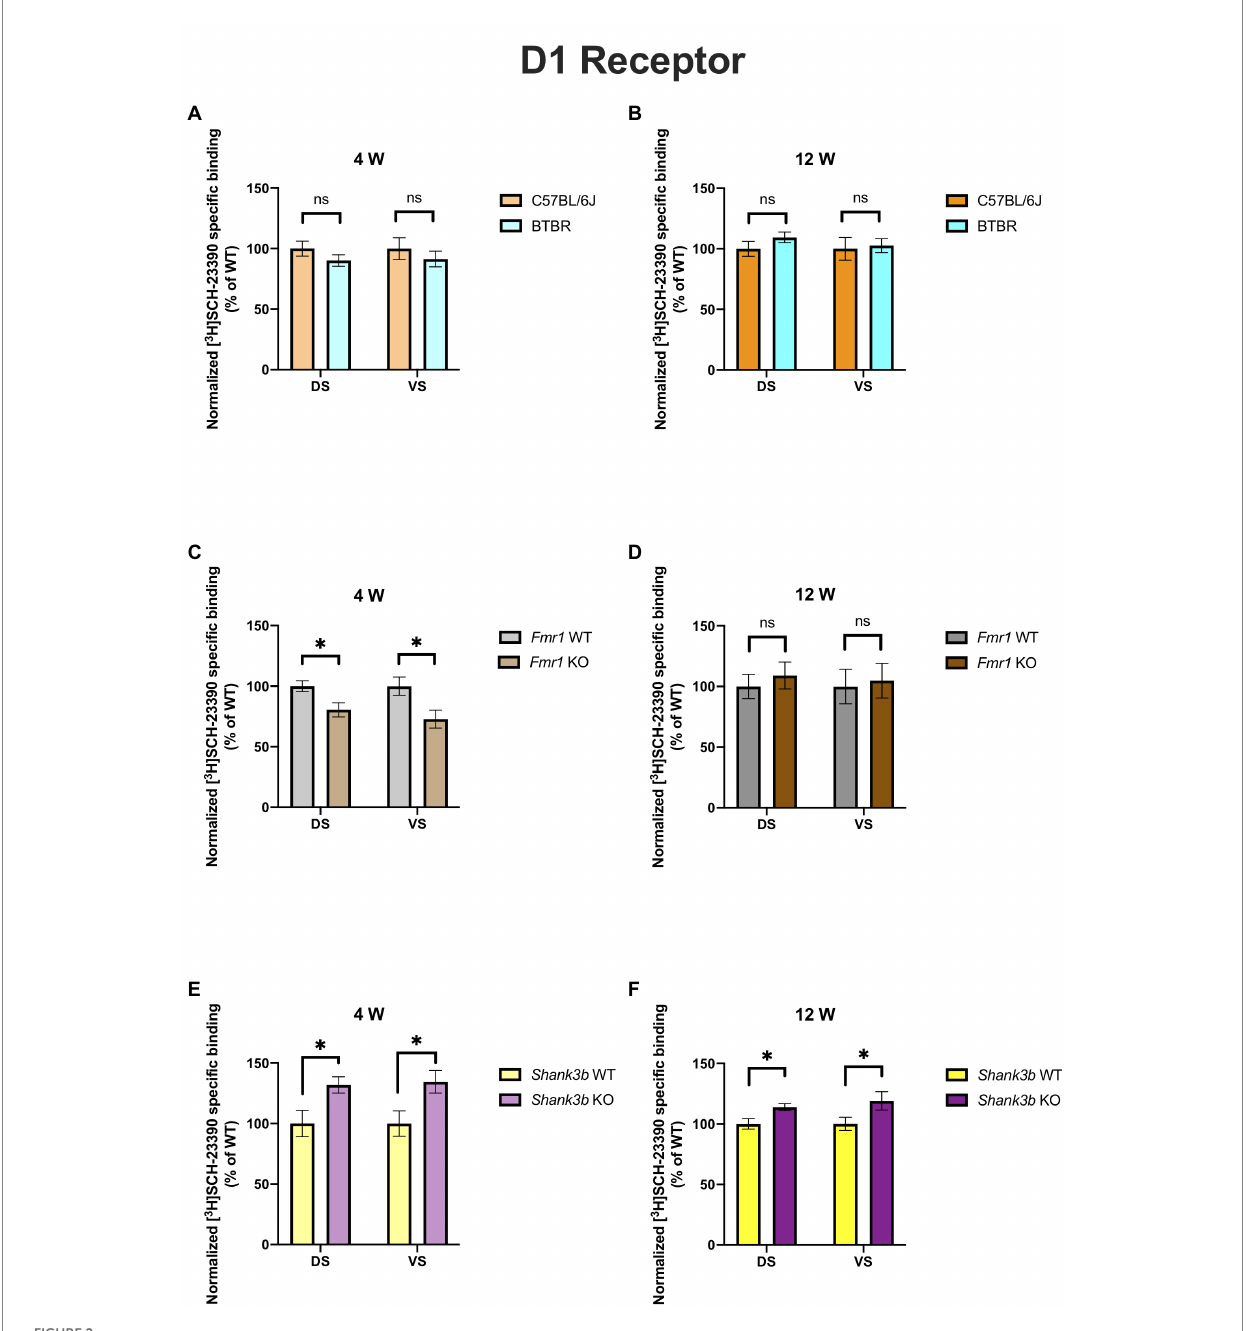
FIGURE 2 Bar charts representing mean and SEM of the receptor density for D1 receptors. DS: C57BL6/J ( n = 8), BTBR ( n = 8) and VS : C57BL6/J ( n = 8), BTBR ( n = 8) at 4 weeks of age (A) ; DS: C57BL6/J ( n = 10), BTBR ( n = 11) and VS : C57BL6/J ( n = 10), BTBR ( n = 11) at 12 weeks of age (B) ; DS: Fmr1 WT ( n = 9), Fmr1 KO mice ( n = 8) and VS : Fmr1 WT ( n = 9) and Fmr1 KO mice ( n = 7) at 4 weeks of age (C) ; DS: Fmr1 WT ( n = 7), Fmr1 KO mice ( n = 8) and VS : Fmr1 WT ( n = 7) and Fmr1 KO mice ( n = 8) at 12 weeks of age (D) ; DS: Shank 3b WT ( n = 5), Shank3b KO mice ( n = 6) and VS : Shank 3b WT ( n = 5), Shank3b KO mice ( n = 6) at 4 weeks of age (E) ; DS: Shank 3b WT ( n = 14), Shank3b KO mice ( n = 12) and VS : Shank 3b WT ( n = 14) and Shank3b KO mice ( n = 12) at 12 weeks of age (F) . Significant differences are indicated with an asterisk (* p < 0.05). Changes are represented as percentage of the mean of C57BL6/J, Fmr1 WT, Shank3b WT mice,